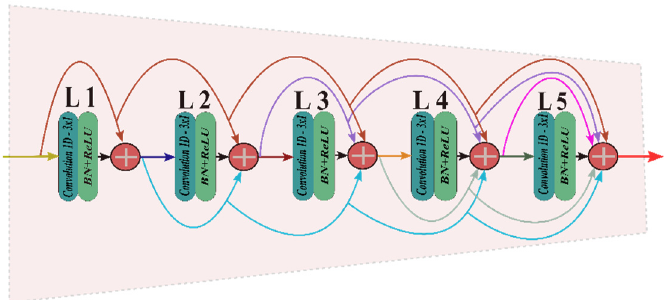
Figure 4. The architecture of DCB.